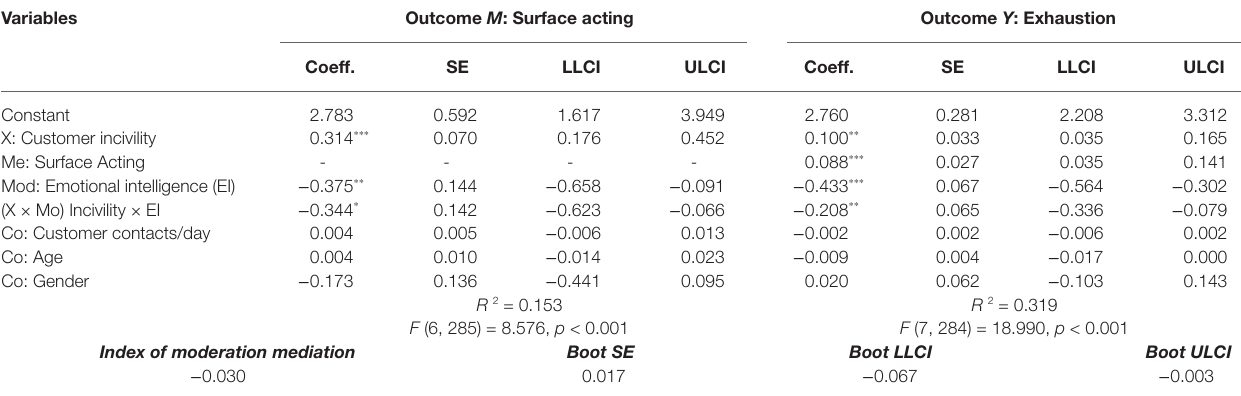
TABLE 4 | Coefficients for the tested moderated mediation model. Variables Outcome M : Surface acting